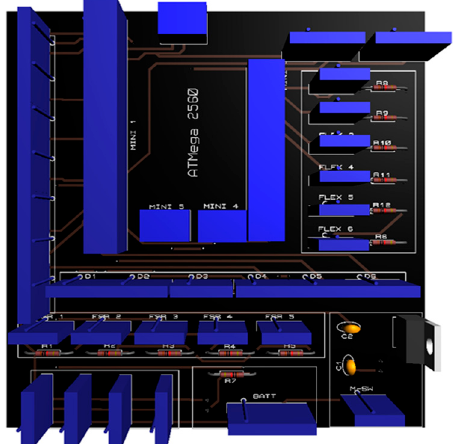
Figure 10. CAD model of the PCB designed.